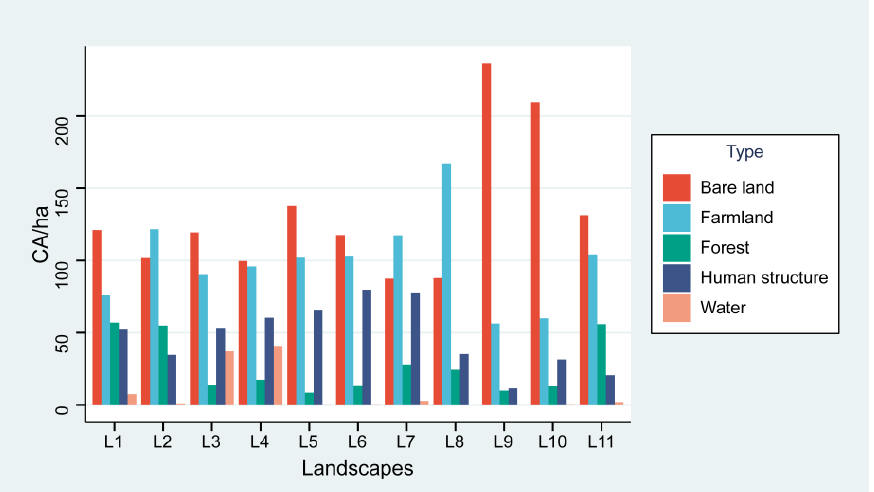
Figure 3. Area of each land cover in hectares. CA (total class area, ha), L1-L11 (landscape 1 – landscape 11).